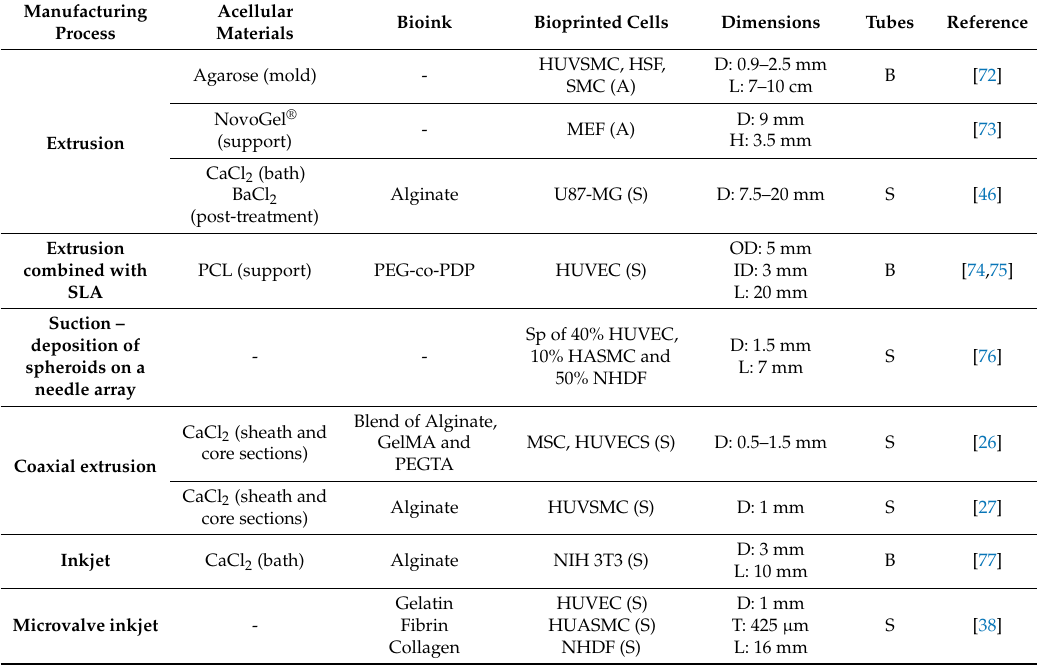
Table 2. Bioprinting (cell-laden bioink printing) B, Branched, S, Straight; A, aggregate, Sp, spheroids, S, cell suspension in bioink; D, Diameter, OD, outer diameter, ID, inner diameter; T, thickness, L, length; HUVSMC, Human Umbilical Vein Smooth Muscle Cells; HSF, Human Splenic Fibroblasts; SMC, Smooth Muscle Cells; MEF, Mouse Embryonic Fibroblasts; U87-MG, Human glioma U87-MG cells; HASMC, Human Aortic Smooth Muscle Cells; NHDF, Normal Human Dermal Fibroblasts; MSC, Mesenchymal Stem Cells; NIH 3T3, Mouse Embryonic Fibroblast Cell Line; HUASMC, Human Umbilical Artery Smooth Muscle